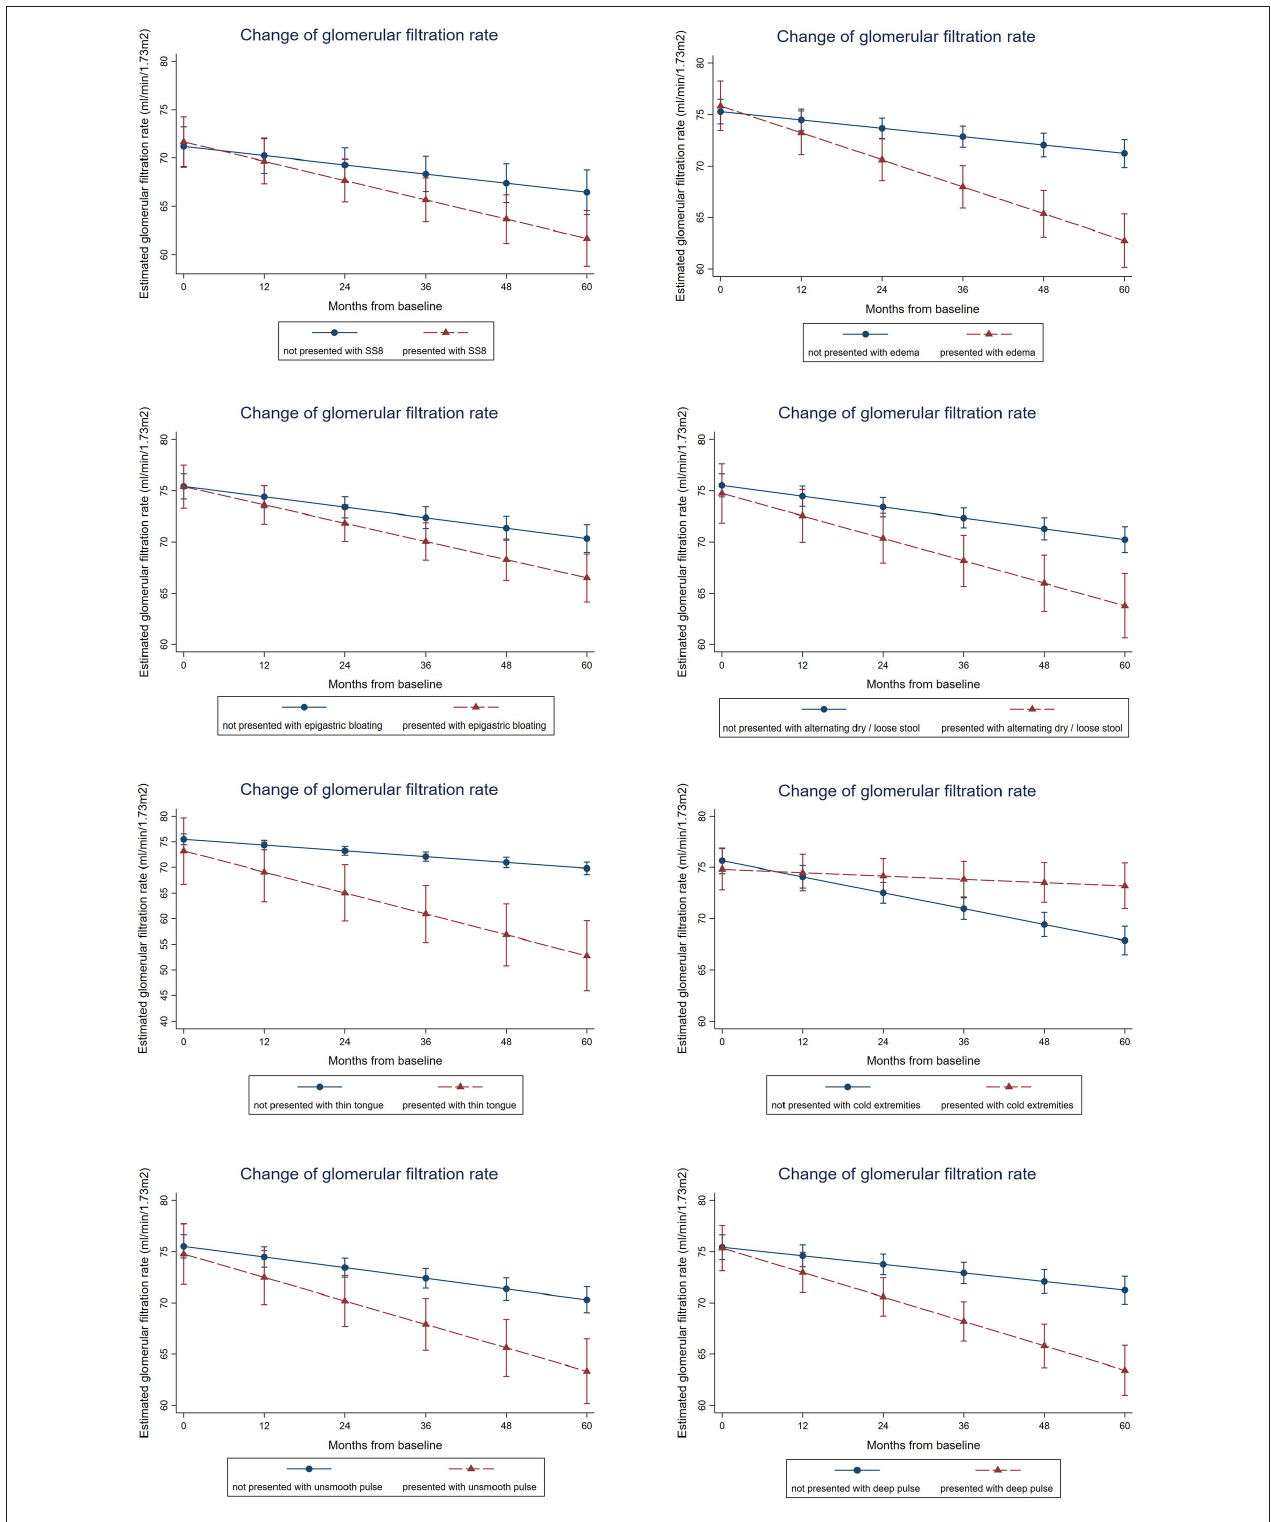
FIGURE 3 | Association between presence of symptoms, symptom clusters and renal function decline over time. Mixed linear growth model on longitudinal repeated measures was used to estimate the slope of GFR change. After adjusting age, gender, type of diabetes, smoking history, alcohol consumption, obesity status, the baseline hemoglobin A1c, systolic blood pressure, low-density lipoprotein, and log-transformed urine albumin-to-creatinine ratio, patients presented with